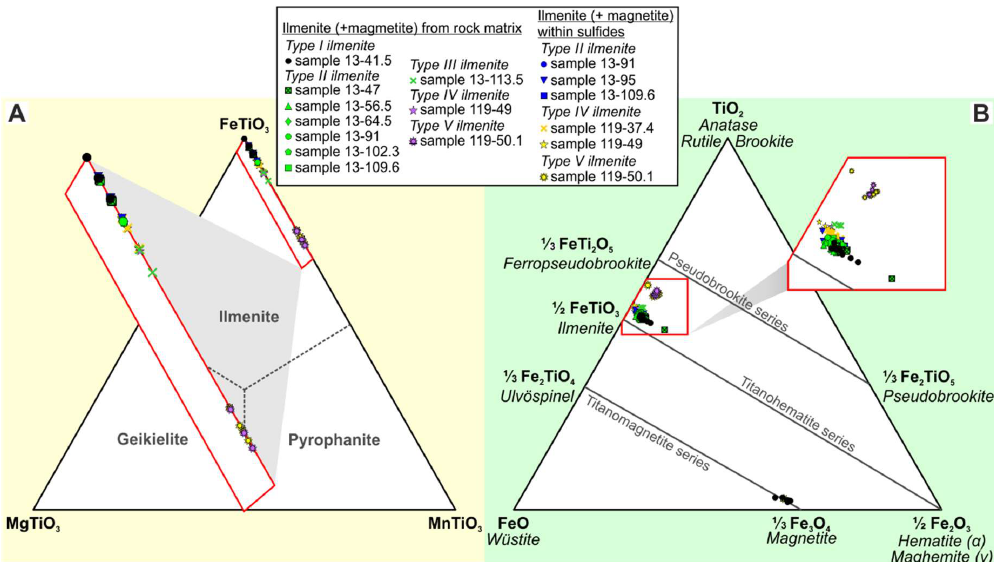
Figure 4. Compositions of ilmenite and Ti-magnetite from the metamorphosed mafic-ultramafic rocks